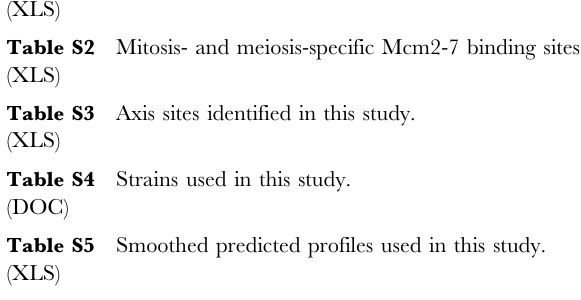
Figure S7 Axis sites. Genome-wide localization analysis was performed for Rec8 (shown in purple), in wild-type cells with and without HU (H4471) cdc6-mn cells (H5491) and clb5 D clb6 D cells (H6495). Hop1 localization analysis is shown in green for wild-type